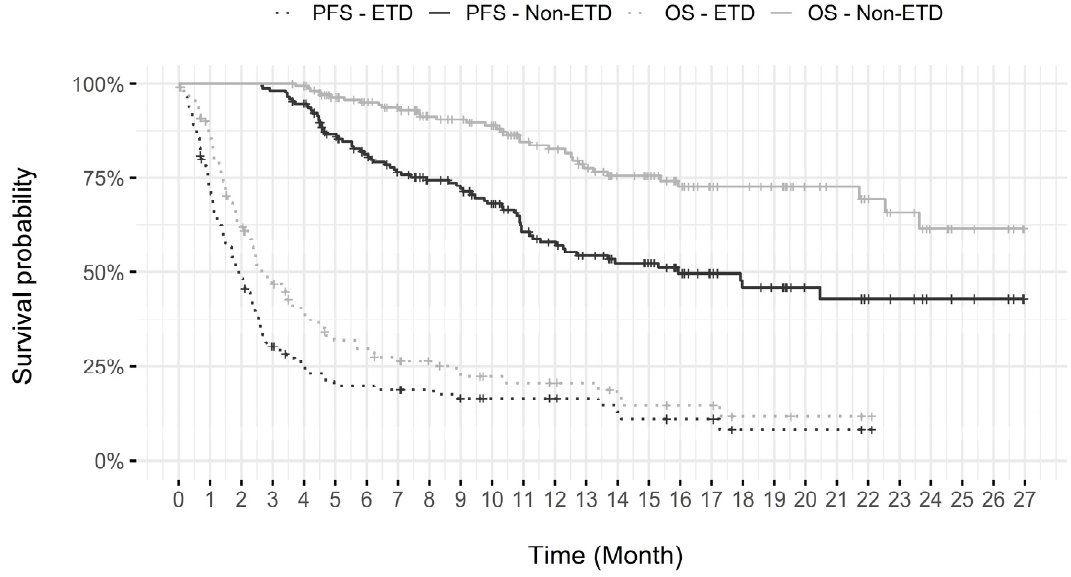
Figure 3. Survival probability of ETD vs.